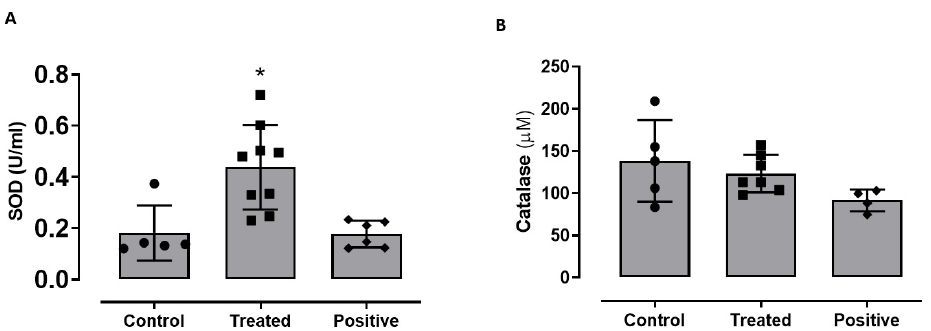
Figure 3. ( A ) SOD and ( B ) catalase levels detected from mice serum. Data are presented as mean ± SEM for n = 4–12 animals. Statistical analysis for was determined by One-way ANOVA (* p < 0.05).